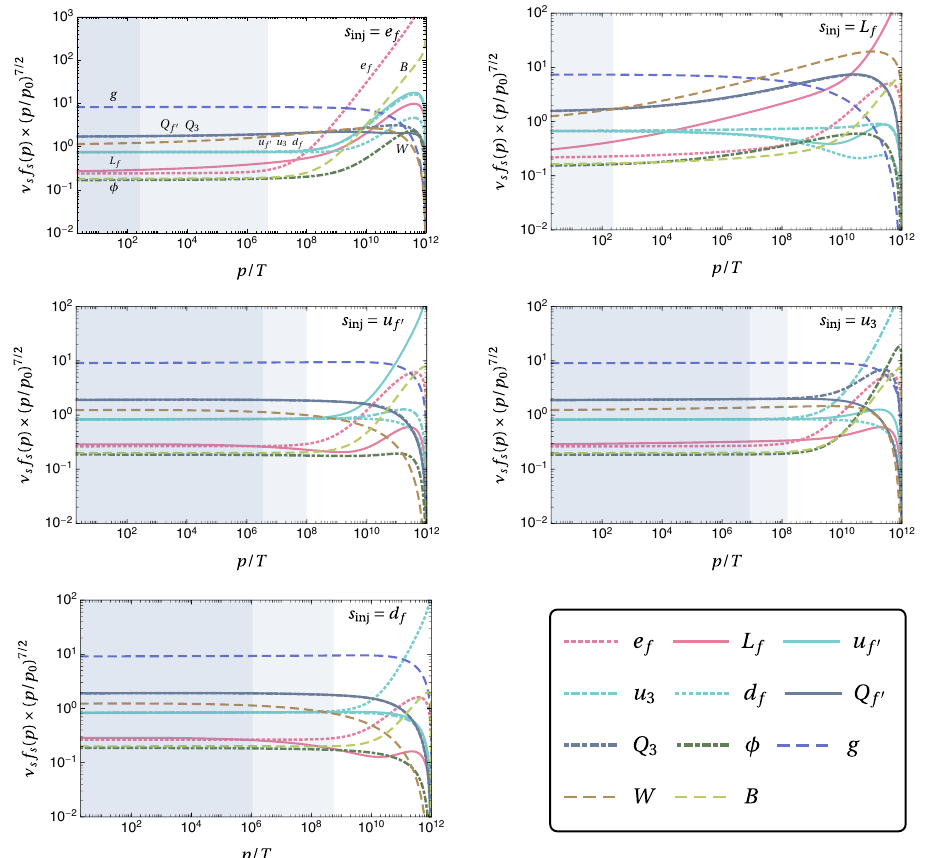
Figure 3 . Particle distributions for each species s , rescaled by ( p/p 0 ) 7 / 2 . The legends for s are shown in the lower right figure. The primary particle s inj is injected solely for e f (upper left), L f (upper right), u f 0 (middle left), u 3 (middle right), and d f (lower left). The dark and light shaded regions represent p < p ( s ) asym and p < p ( s ) , asym 0